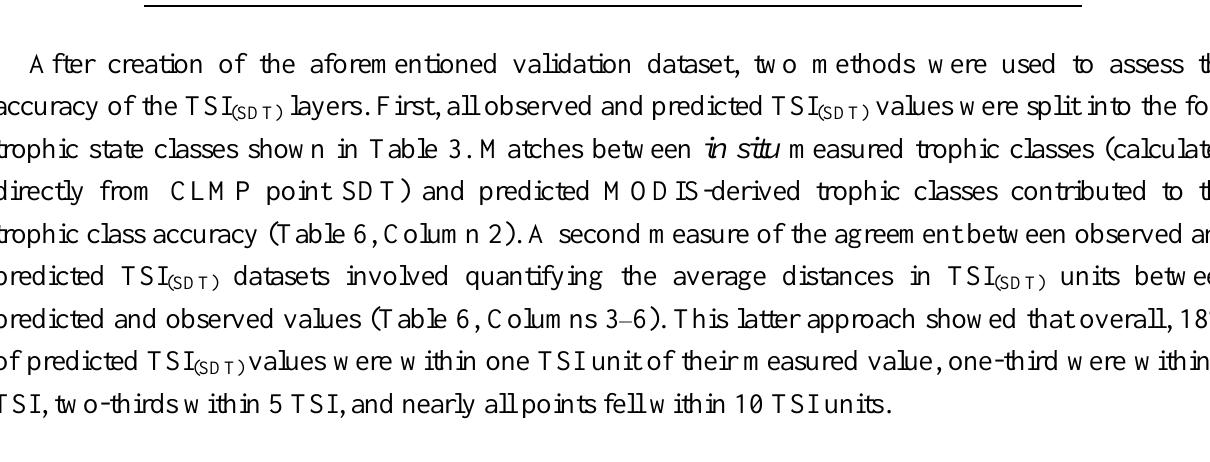
Table 6. Accuracy assessment of MODIS-predicted TSI class accuracy and difference between observed and predicted TSI